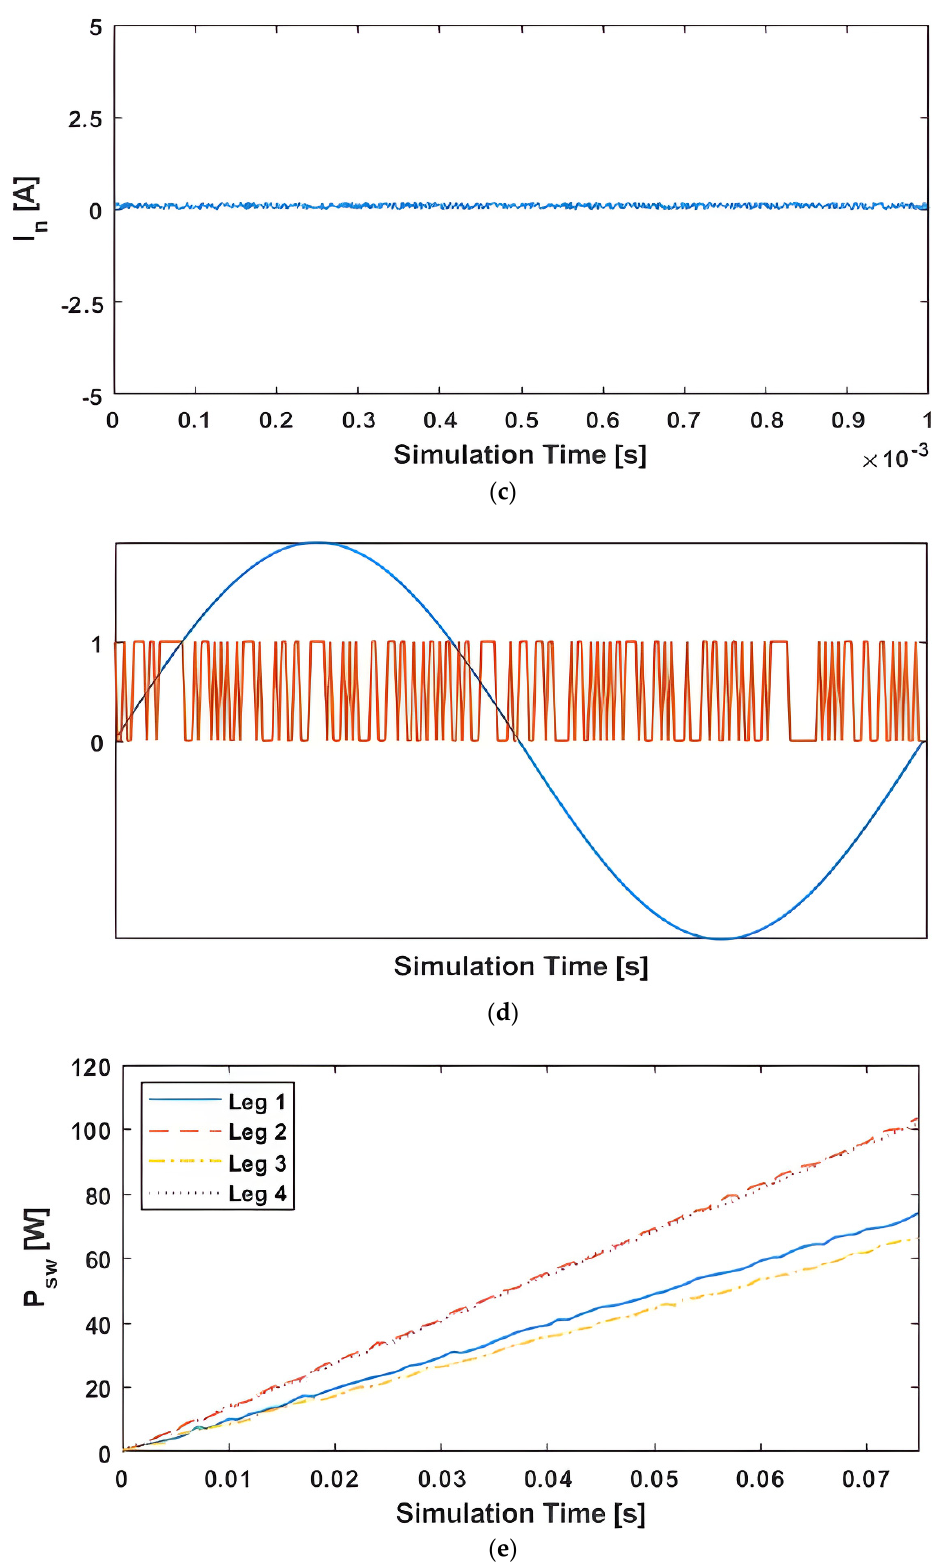
Figure 5. ( a ) V abc -Mode III with Balanced Reference Currents. ( b ) I abc -Mode III with Balanced Reference Currents. ( c ) I n -Mode III with Balanced Reference Currents. ( d ) Switching frequency for one duty cycle-Mode III with Balanced Reference Currents. ( e ) Switching losses-Mode III with Balanced Reference Currents.